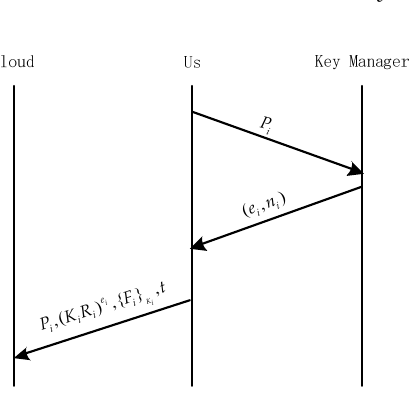
Figure 6. ADSS single KM file upload.